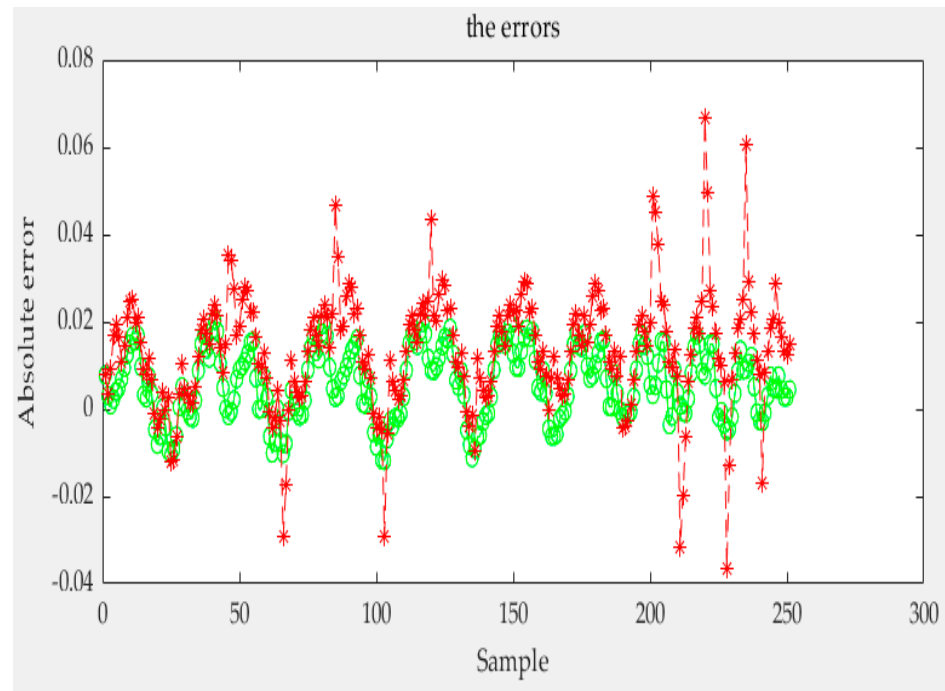
Figure 17. Errors of the first kind sensor for the sparse data.